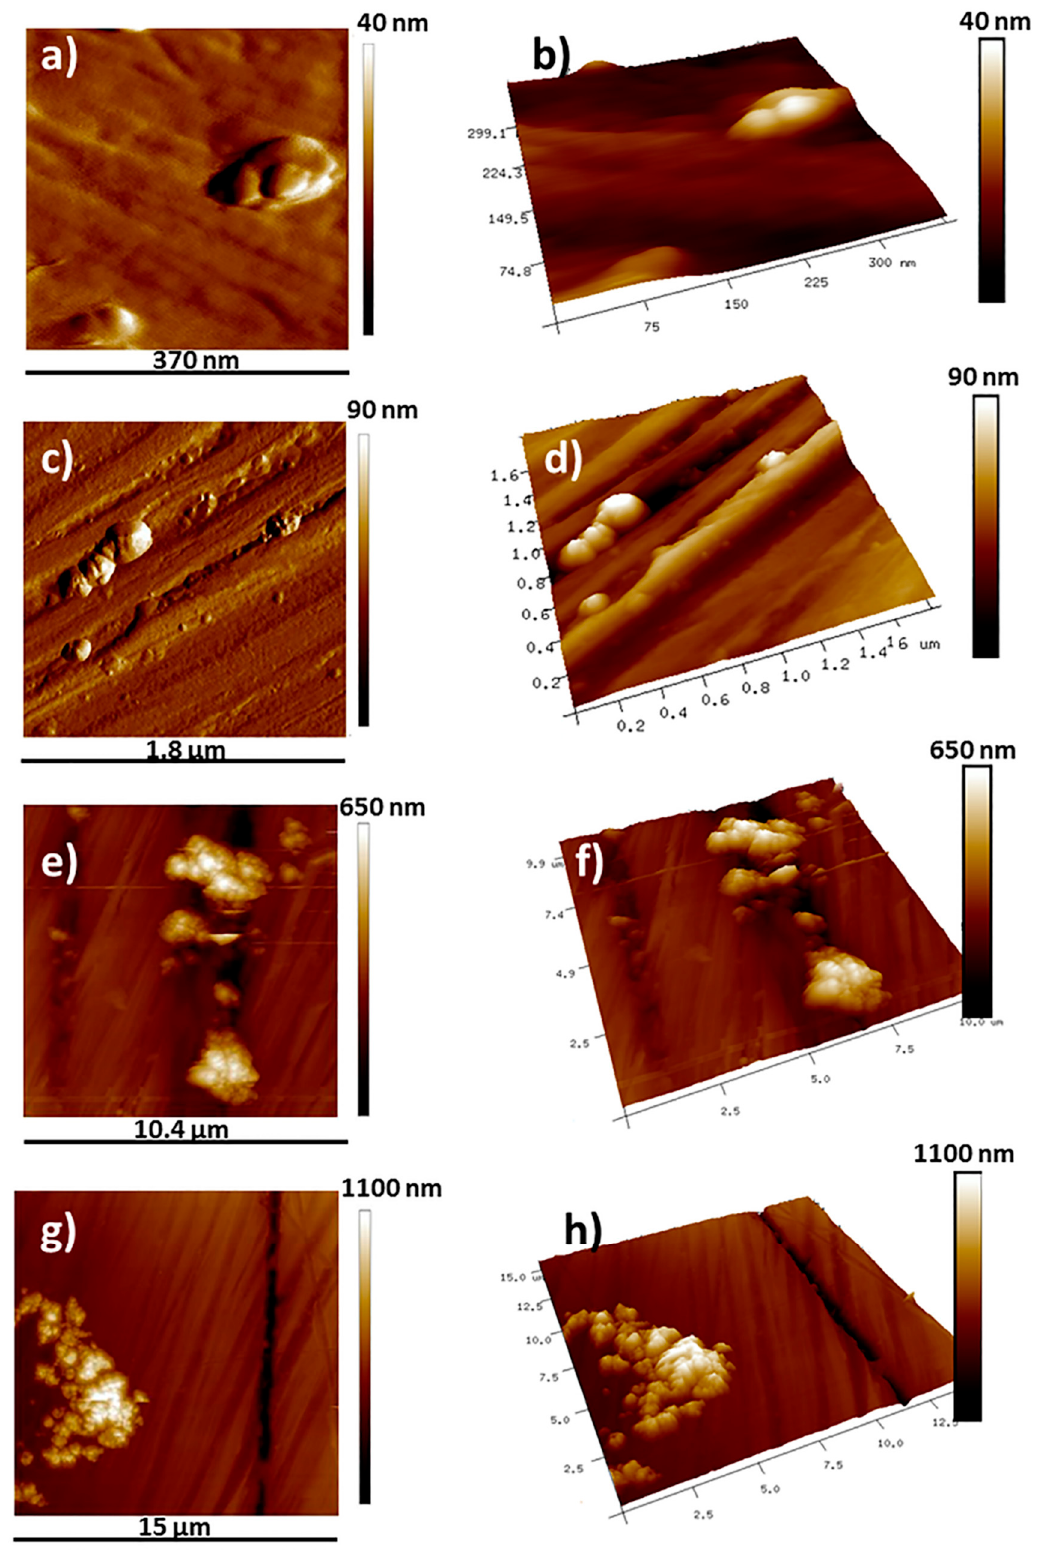
Figure 2. Topographic 2D and 3D AFM images of label-free PET nanoparticles at different scan areas: 0.37 × 0.37 μ m 2 ( a , b ); 1.8 × 1.8 μ m 2 ( c , d ); 10.4 × 10.4 μ m 2 ( e , f ); and 15 × 15 μ m 2 ( g , h ).